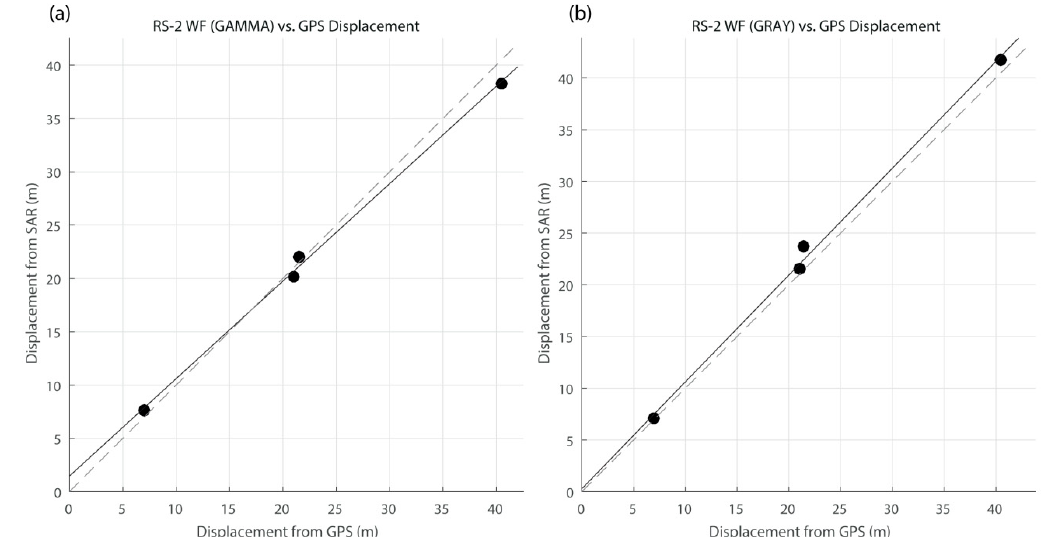
Figure 2. Comparison of displacements of Kronebreen from RS-2 Wide Fine data and GPS: ( a ) RS-2 Wide Fine (GAMMA) vs. GPS; and ( b ) RS-2 Wide Fine (GRAY) vs. GPS. Solid line: regression line. Dashed line: line of equality (y = x). For GPS data see Schellenberger et al. [19], courtesy of J. Kohler (Norwegian Polar Institute) and C. Reijmer (Utrecht University).